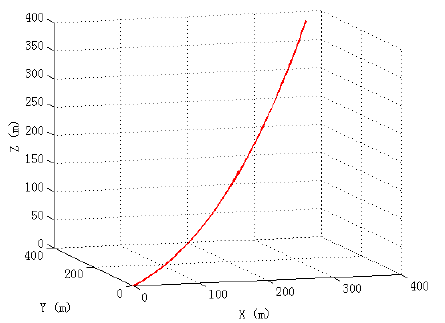
Figure 17. Wave spectrum.